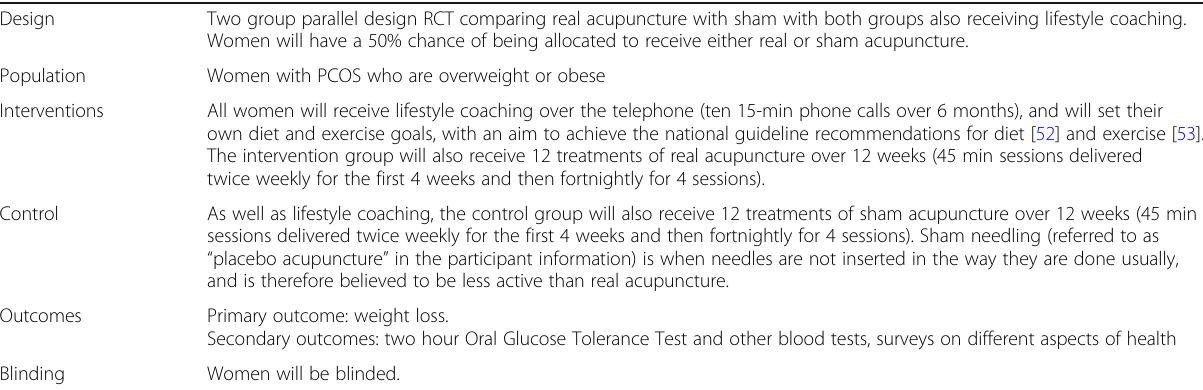
Table 1 Details of the proposed RCT methodology which were provided to participants